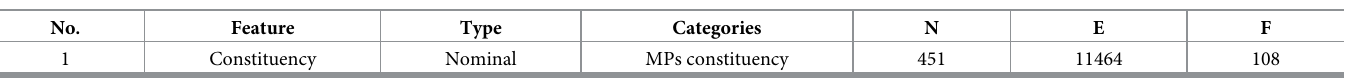
Table 4. The Parliament data set. No.